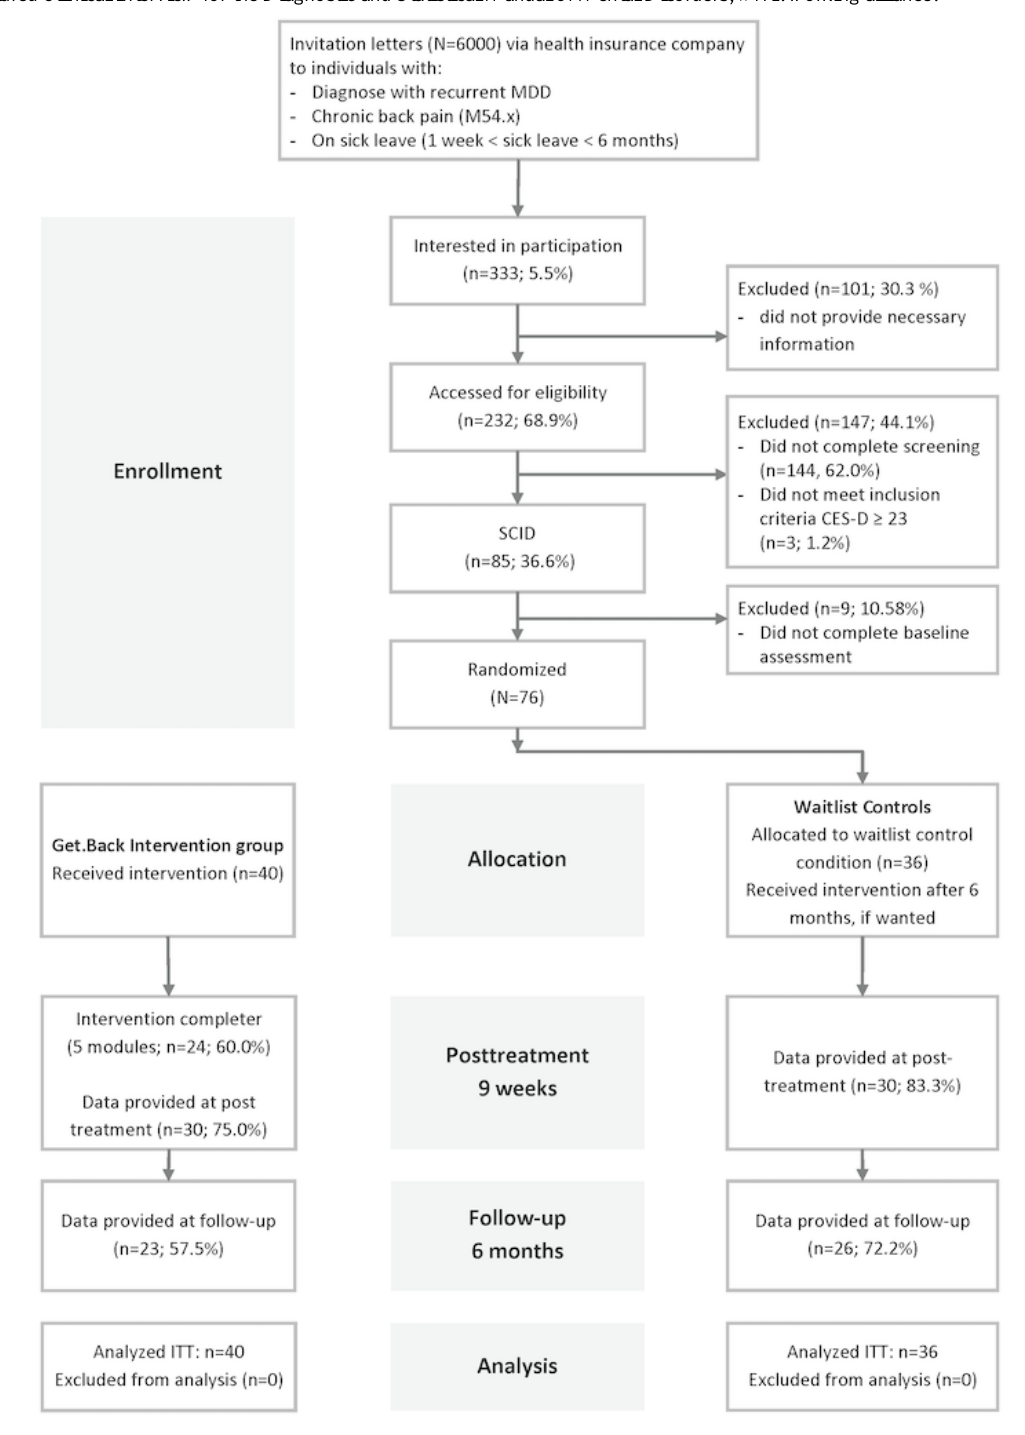
Figure 1. Flowchart for Get.Back. CES-D: Center for Epidemiological Studies Depression; ITT: intention-to-treat; MDD: major depressive disorder; SCID: Structured Clinical Interview for the Diagnostic and Statistical Manual of Mental Disorders; WAI: working